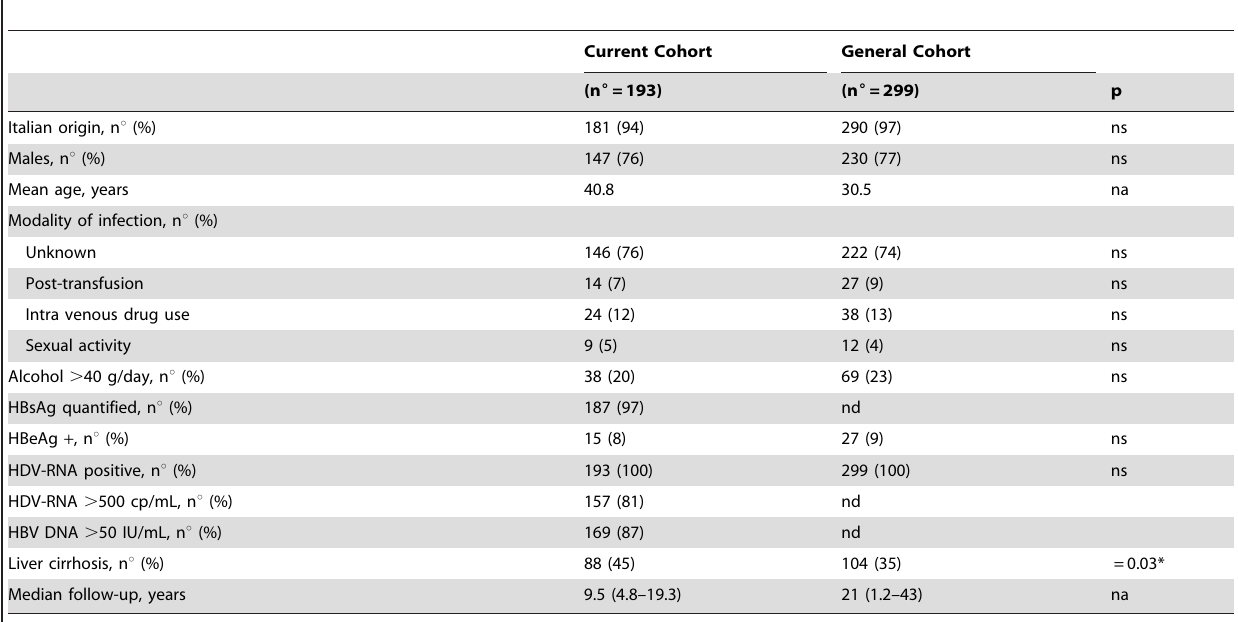
Table 1. Comparison of the main epidemiological and virological characteristics of the 193 patients (current cohort) and 299 patients (general cohort [8]) at study entry.